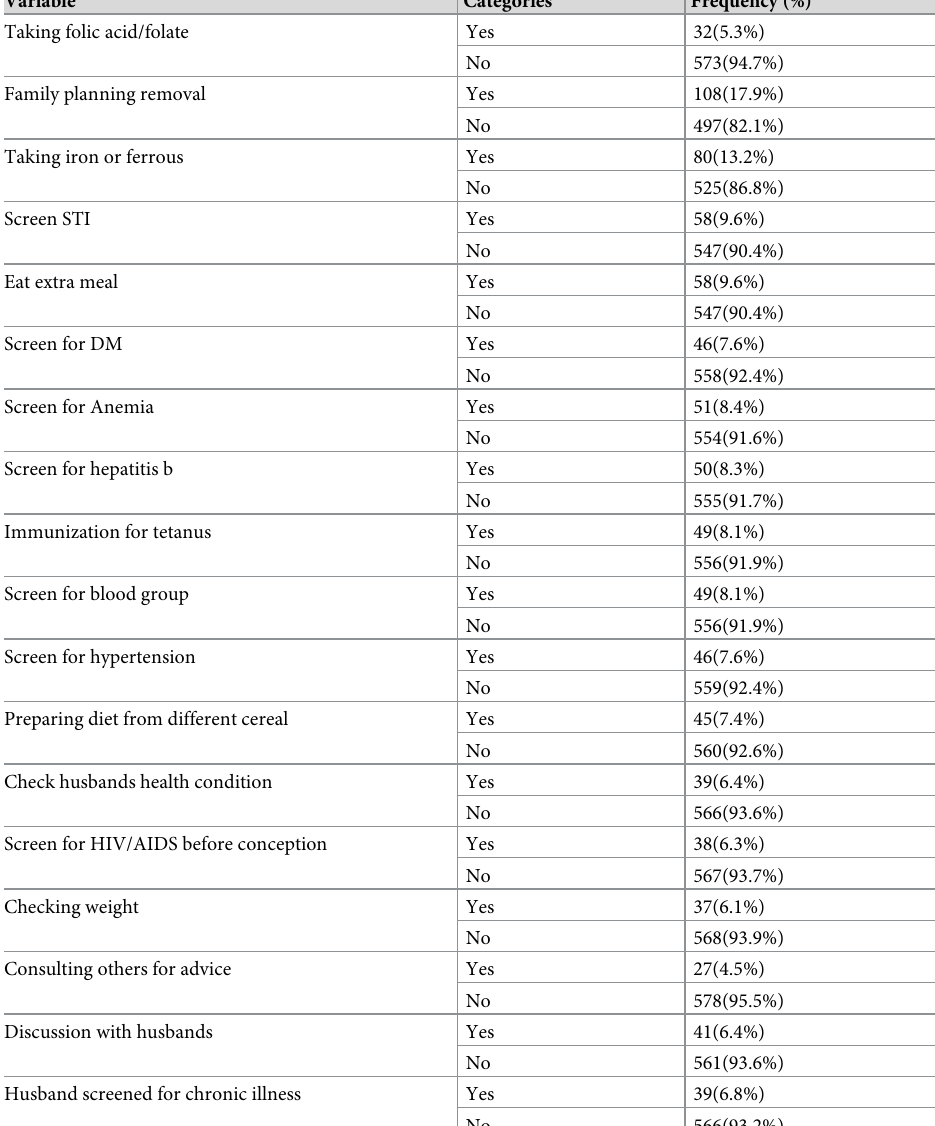
Table 4. Preconception care component utilization among reproductive age women in Mizan-Aman town south- west Ethiopia, 2020(n =